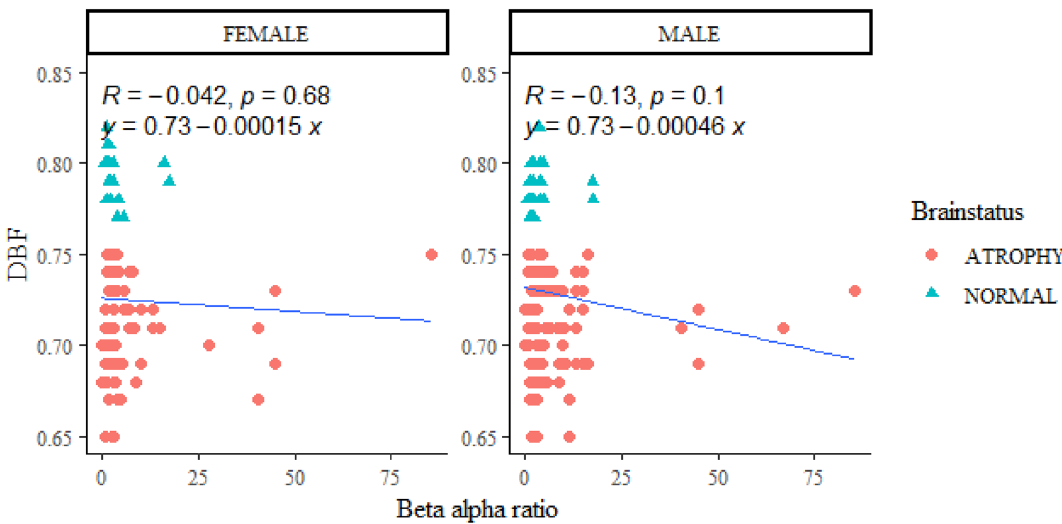
Figure 7. Gender relation of focused occipital bar. No significant difference between male and female subjects was found, despite an increased trend towards male children.